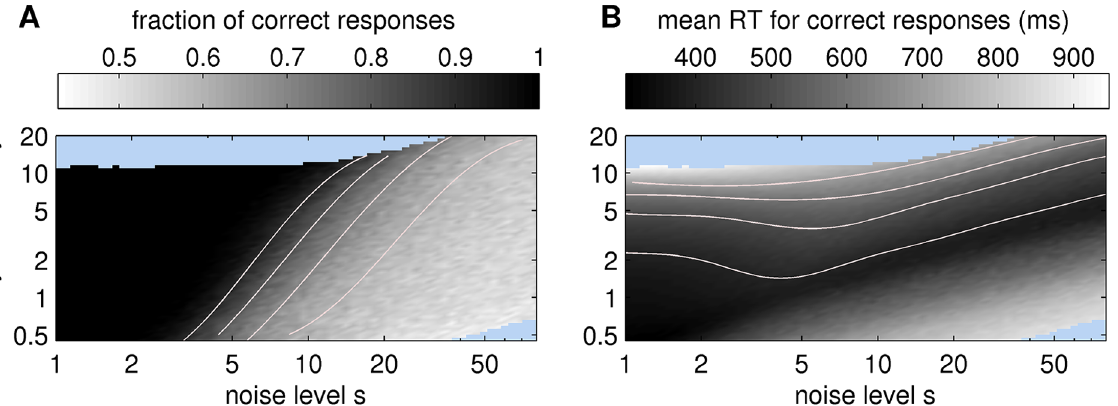
Fig 6. Mapping from sensory uncertainty r and noise level s to behavioural measures. (A) Log-log plot of the fraction of correct responses, i.e. accuracy. (B) Mean reaction time for correct responses in ms (including a non-decision time of 200ms, see Methods). Light blue areas correspond to parameter settings where more than 50% of trials resulted in time outs (RT > 1000ms). Light red lines show approximated contour lines (see Methods of the underlying grey scale map. In A the lines correspond, from right to left, to 0.6, 0.7, 0.8 and 0.9 fraction of correct responses. In B the lines correspond, from bottom to top, to 400, 500, 600 and 700